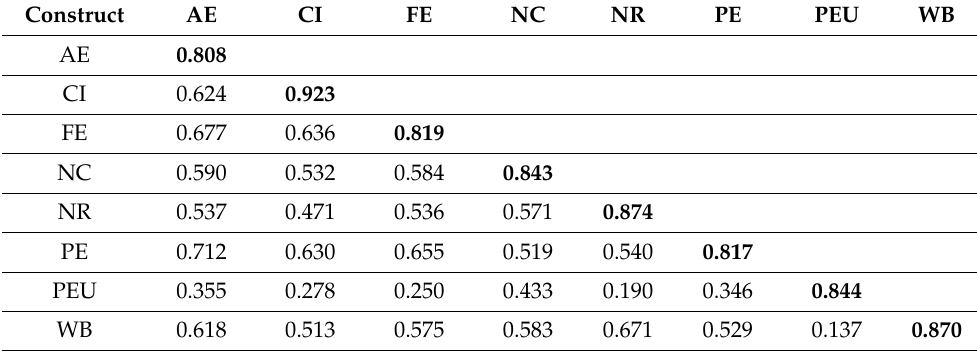
Table 3. Measurement model